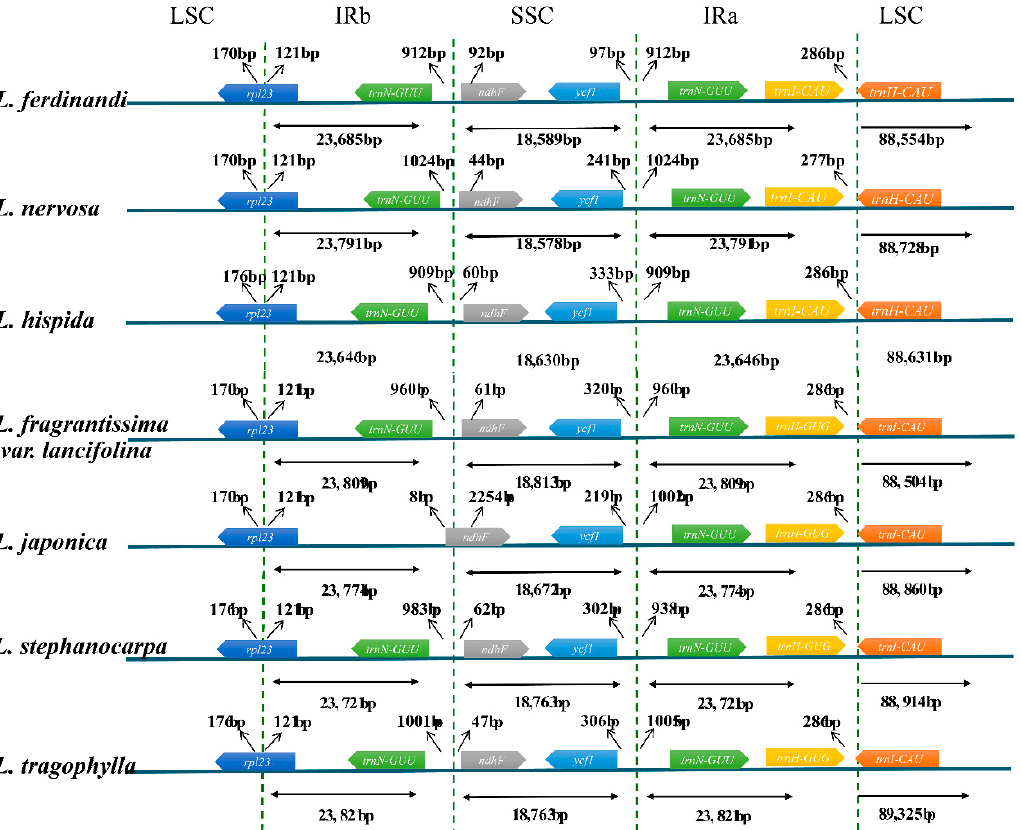
Figure 6. Comparison of the border positions of large single copy (LSC), small single copy (SSC), and inverted repeat (IR) regions in the chloroplast genomes in seven Lonicera species.